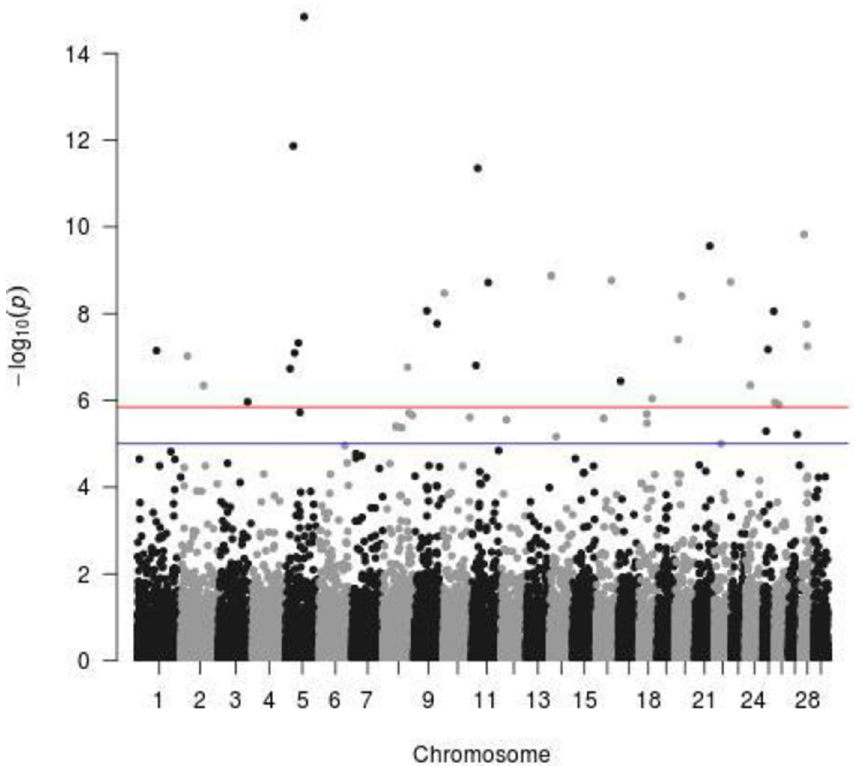
Fig 2. Significant SNPs for the ear position trait (blue line = indicative threshold–log10(p) = 5; red line = Bonferroni threshold–log10(p) = 5.86).